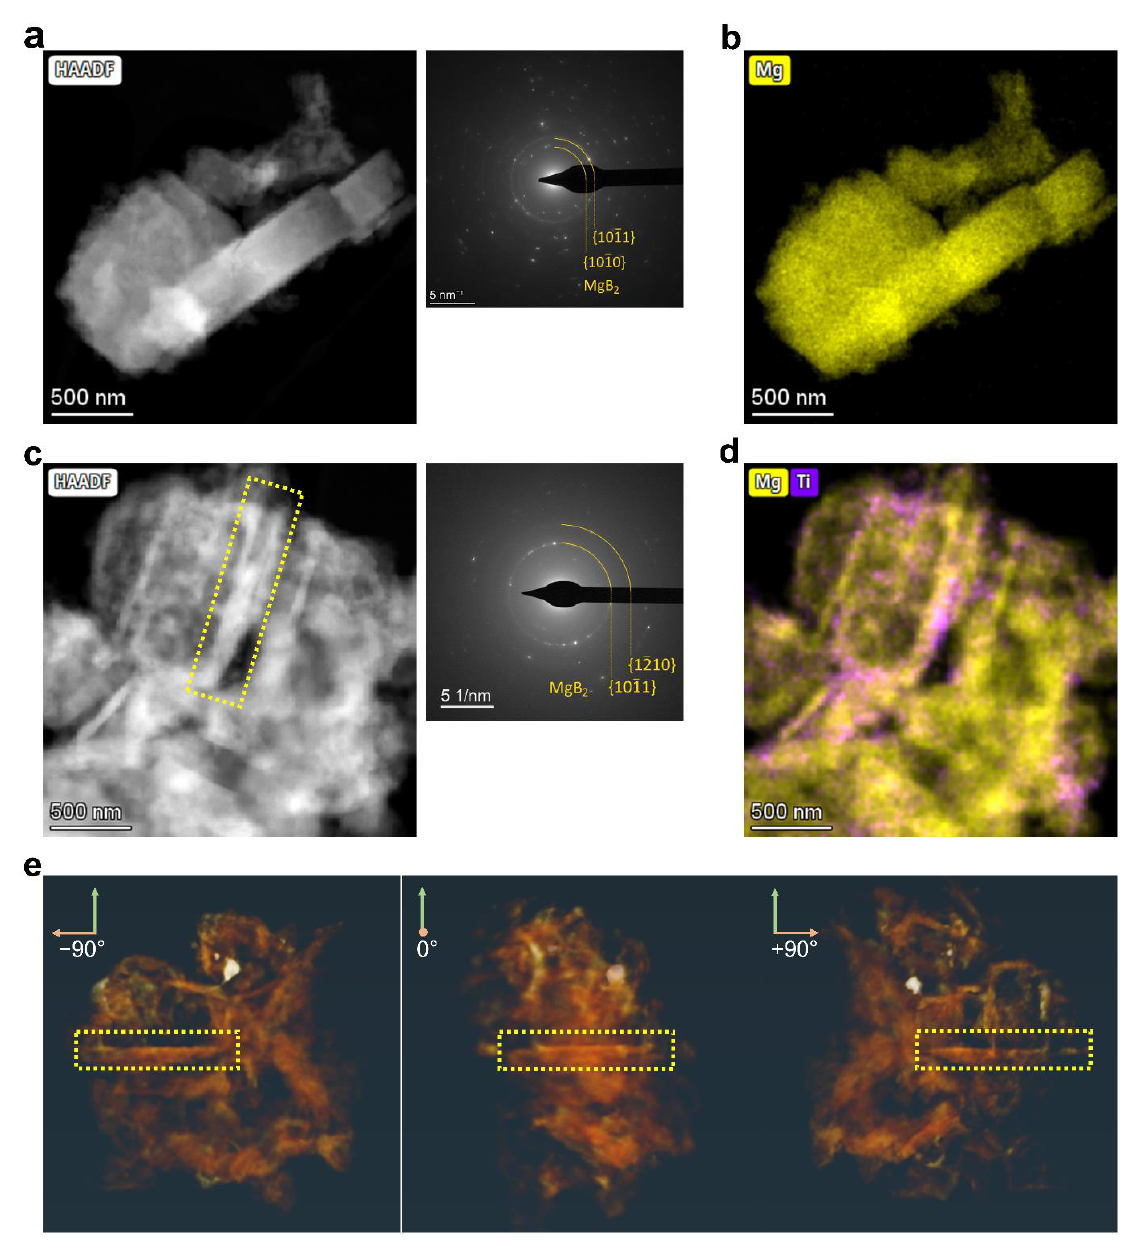
Figure 5. Desorbed 2LiBH 4 –MgH 2 with 2.5 mol% or 5 mol% 3TiCl 3 · AlCl 3 : ( a ) STEM-HAADF image and the corresponding DP of desorbed 2LiBH 4 –MgH 2 with 2.5 mol% 3TiCl 3 · AlCl 3 ; ( b ) EDX elemental map of Mg (K lines) acquired in the same position as image (a); ( c ) STEM-HAADF image and the corresponding DP of desorbed 2LiBH 4 –MgH 2 with 5 mol% 3TiCl 3 · AlCl 3 ; ( d ) Summed EDX elemental map of Mg (K lines) and Ti (K lines) acquired in the same position as image ( c ); ( e ) STEM tomography images acquired in the same region as image ( c ) visualized at the angle − 90 ◦ , 0 ◦ and +90 ◦ . The selected MgB 2 platelet highlighted in the yellow box is exactly the one highlighted in image ( c